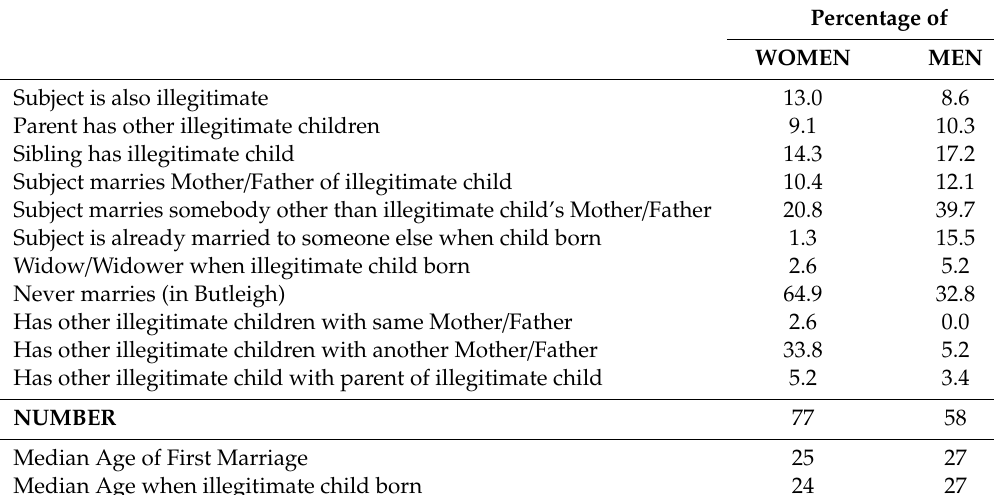
Table 4. Characteristics of Parents of Illegitimate Children Receiving Poor Relief, Butleigh 1762–1834